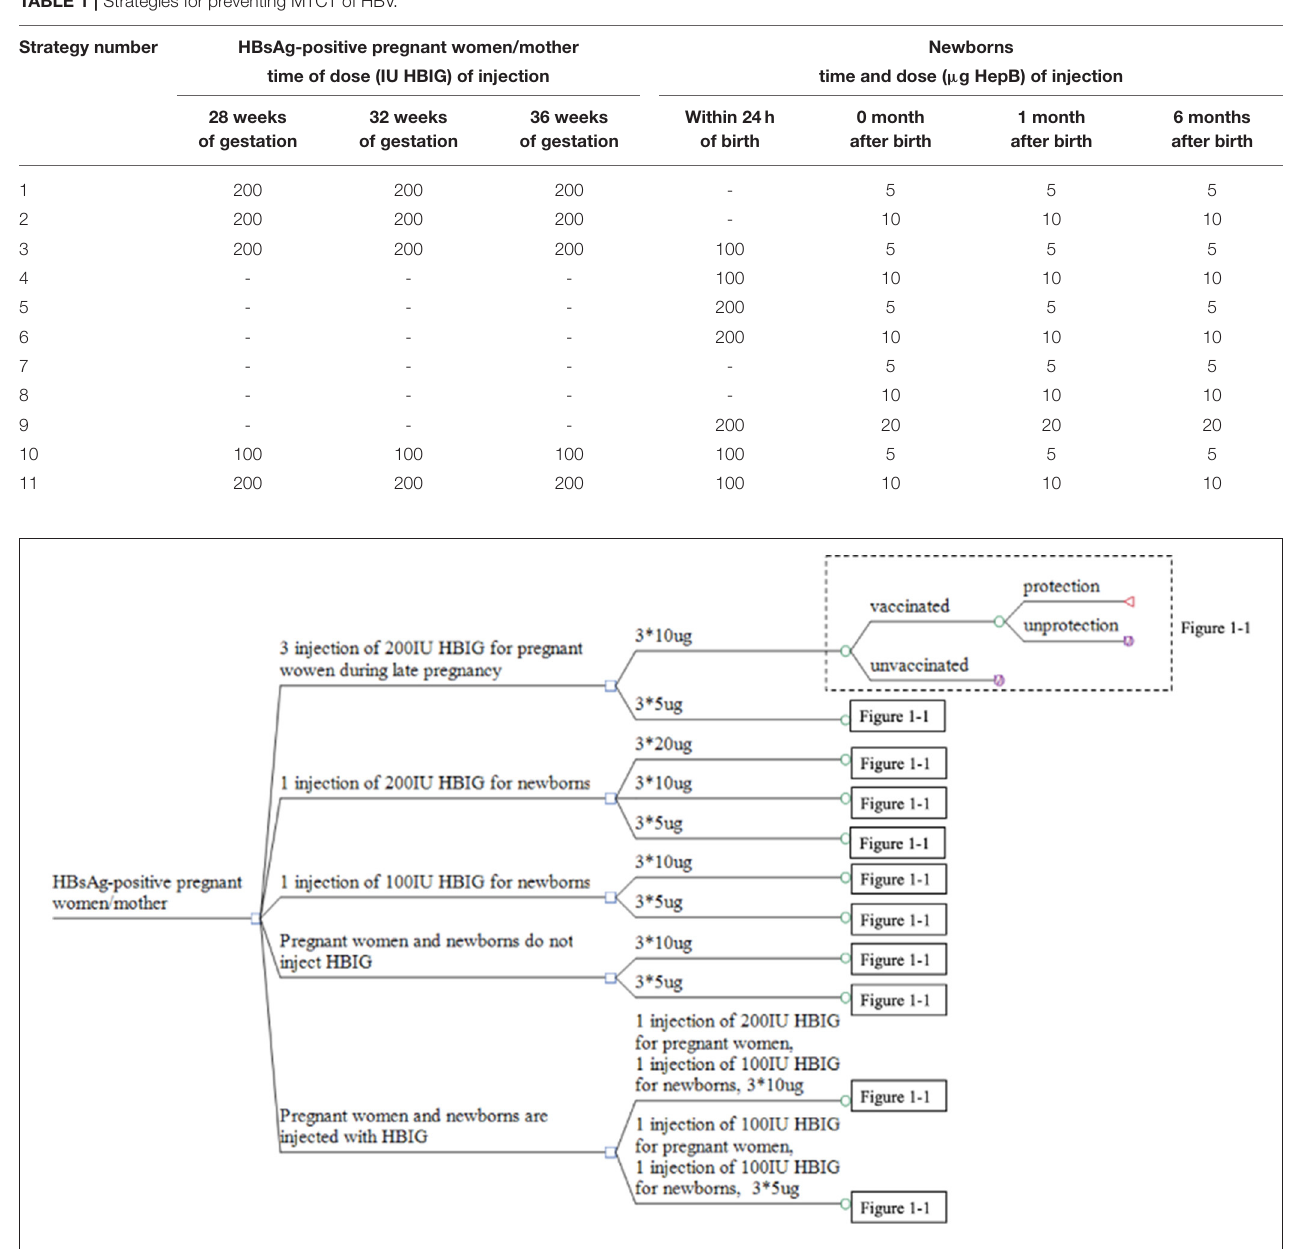
TABLE 1 | Strategies for preventing MTCT of HBV.